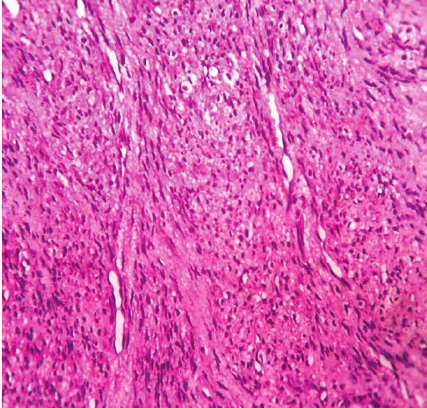
Figure 4: Groups of densely packed cells adjacent to angular hemangiopericytoma-like blood vessels (H&E stain, original mag- nification × 40).